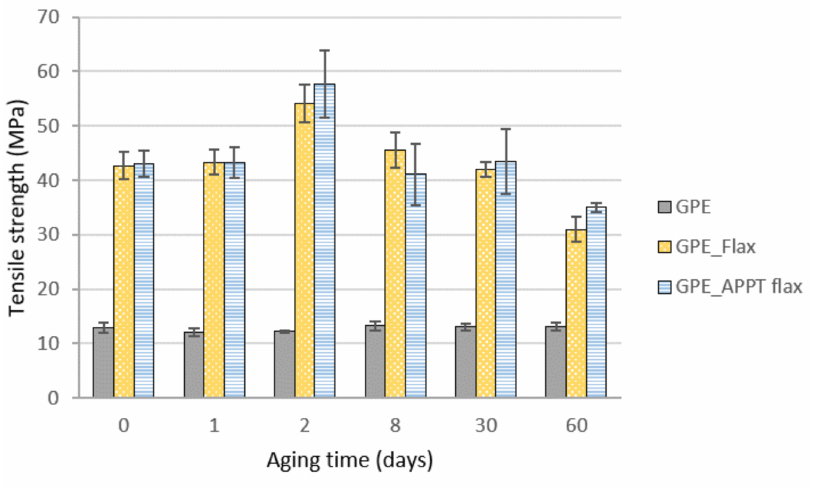
Figure 13. FTIR spectra for ( a ) PBS composites before and after aging time, ( b ) Detail of the overlapped spectra in the water absorption band between 3000 and 3500 cm − 1 and ( c ) Detail of the overlapped spectra in the C = O absorption band between 1650 and 1750 cm − 1 .